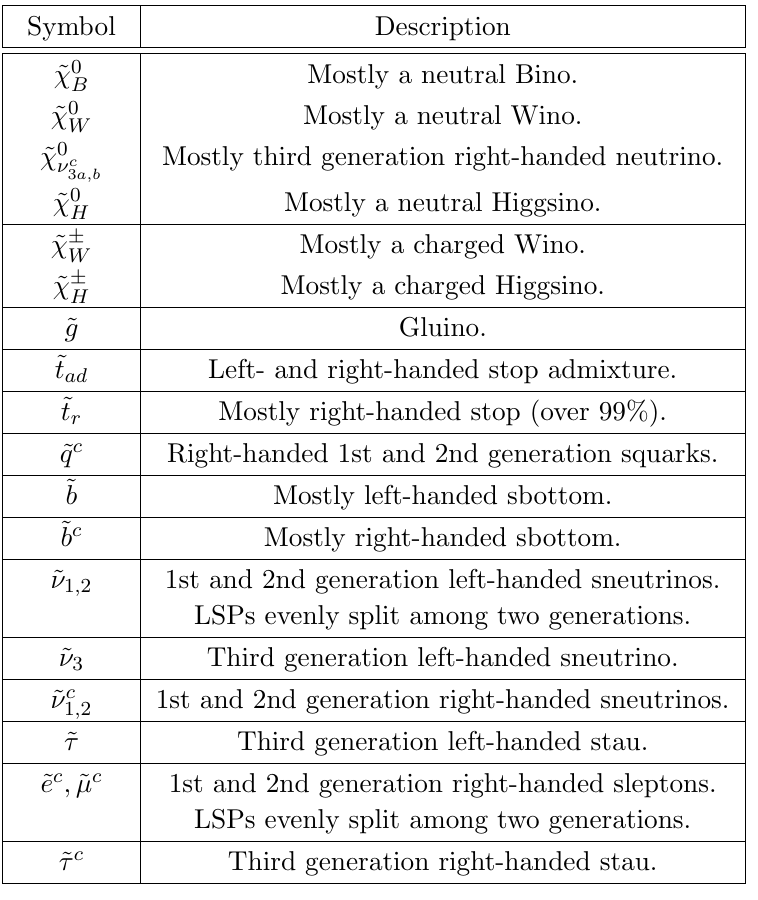
Table 2. The notation used for the LSP states on the x-axis of (cid:12)gure